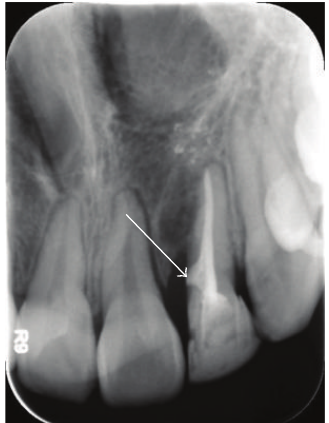
Figure 6: Removing of the mesial part.